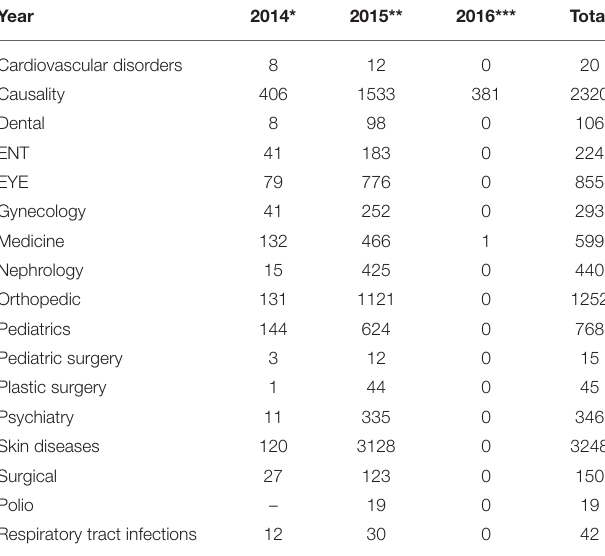
TABLE 5 | Health status of IDPs in Peshawar.